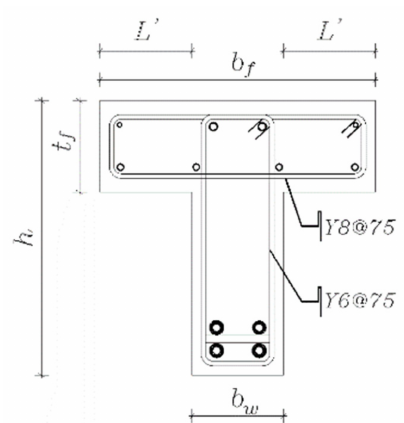
Figure 9. Cross-section. Range of parameters considered: width ratio ( ρ b = b f /b w ) ≤ 5, depth ratio ( ρ t = t f /h ) up to 1, L’ ≤ 2b w ; where L’ is the left/right protruded part of the